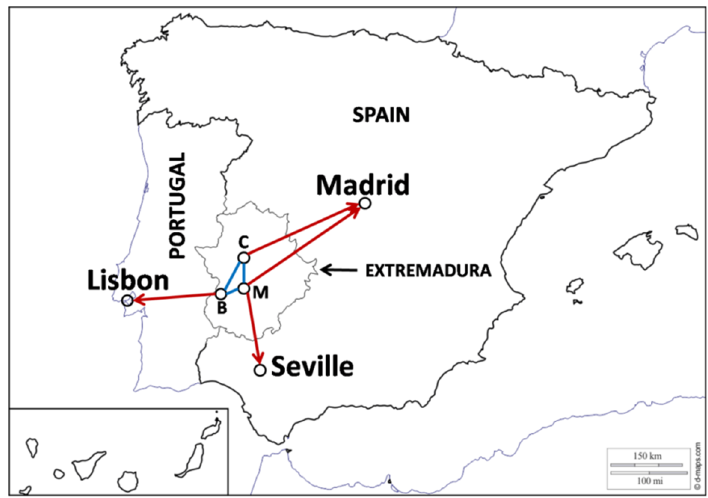
Figure 2. Main connections of cities from Extremadura (Badajoz, B; Cáceres, C; Mérida, M) with other cities in the Iberian Peninsula. Original map obtained on © d-maps.com, accessed from https: //d-maps.com/carte.php?num_car=2199&lang=es.